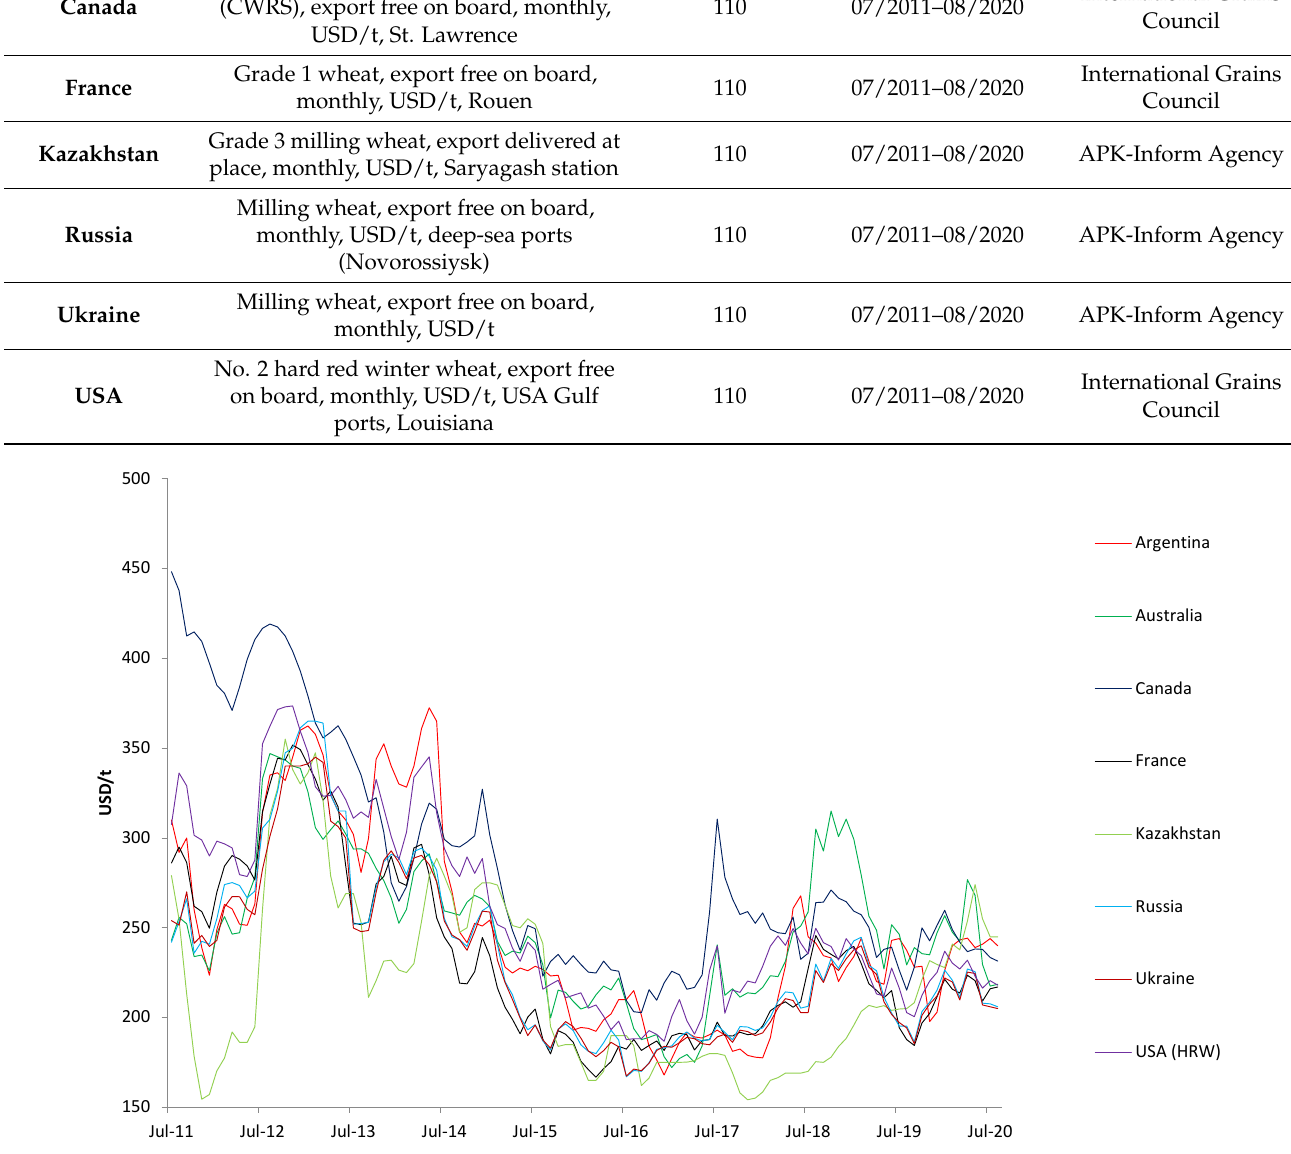
Figure 4. World wheat prices (2011–2020). Source: See data sources in Table 1.